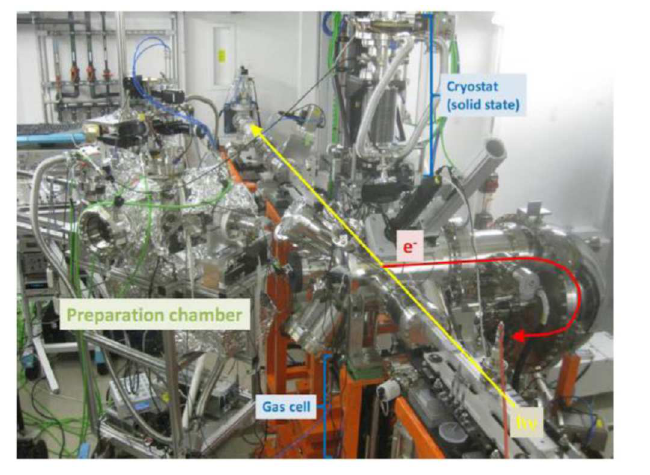
Fig. 1. Photo of the HAXPES endstation of the SOLEIL GALAXIES